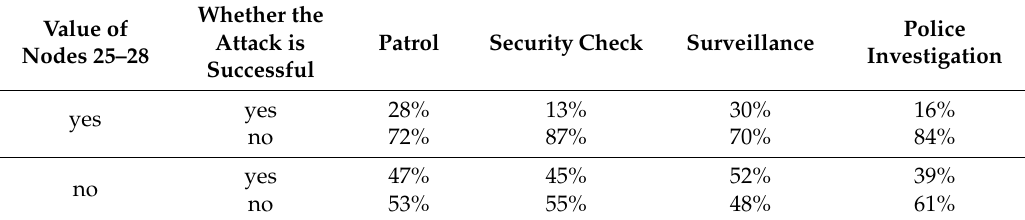
Table 6. Sensitivity of “Whether the attack is successful” to patrol, security check, surveillance, police